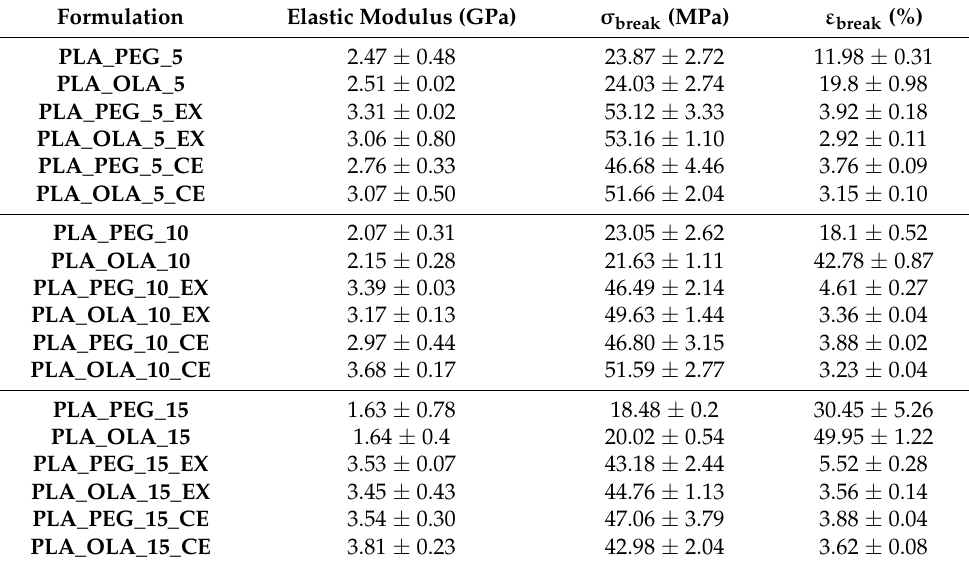
Table 2. Tensile properties of lab-scale films production.